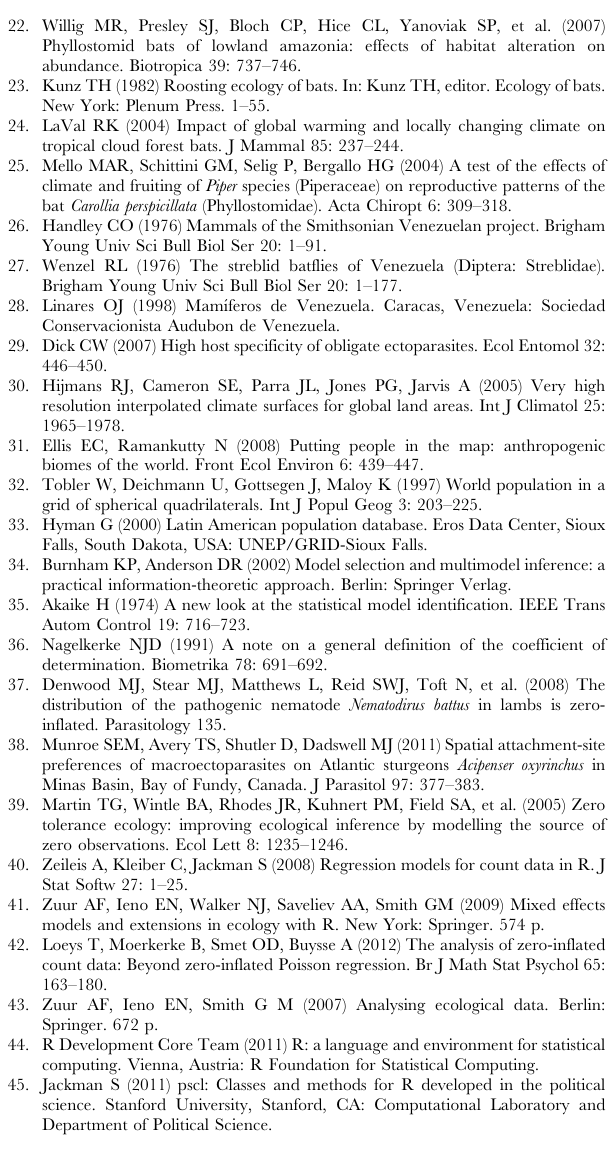
Table S1 Mean values of the factors used in our models, calculated within a 5 km radius for each primary locality.